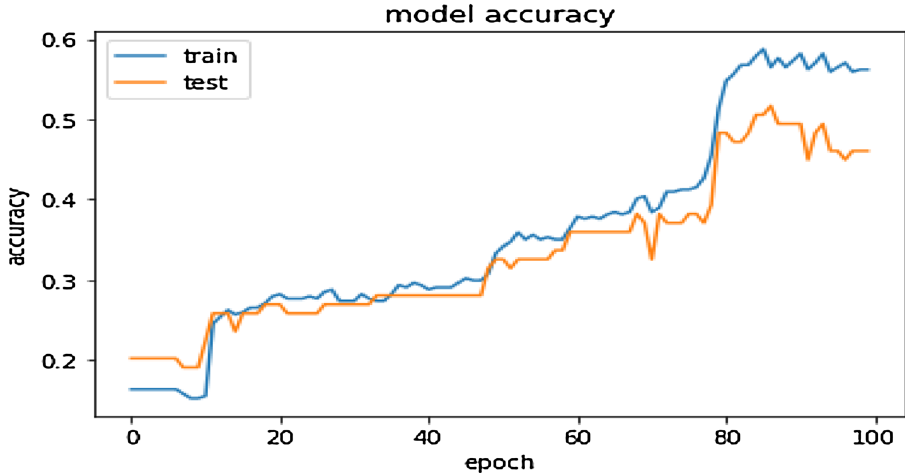
Fig. 2 Validation of model